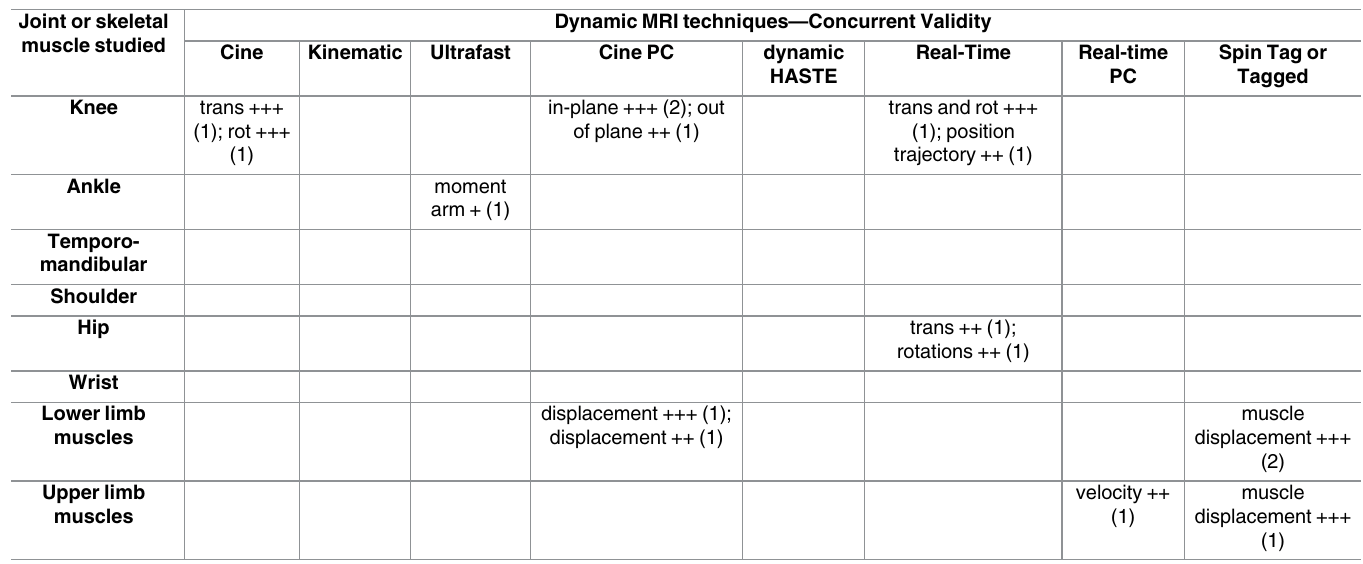
Table 6. Concurrent validity for each joint and muscle studied. Joint or skeletal muscle studied